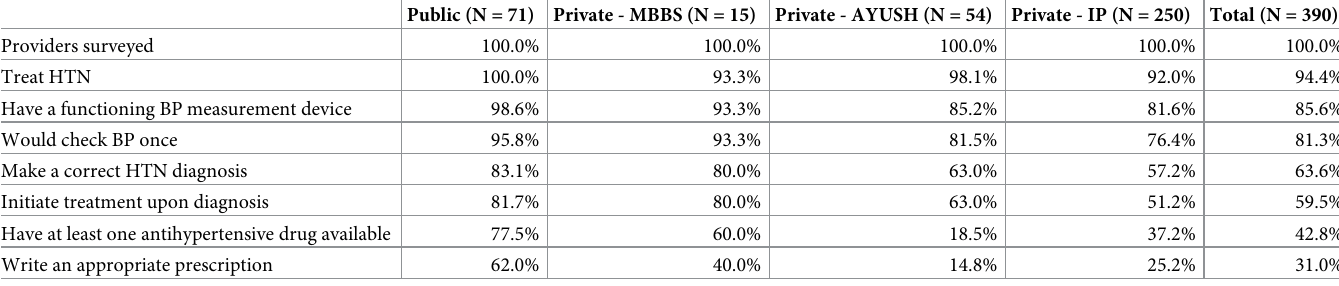
Table 3. Provider cascade of quality hypertension care by provider